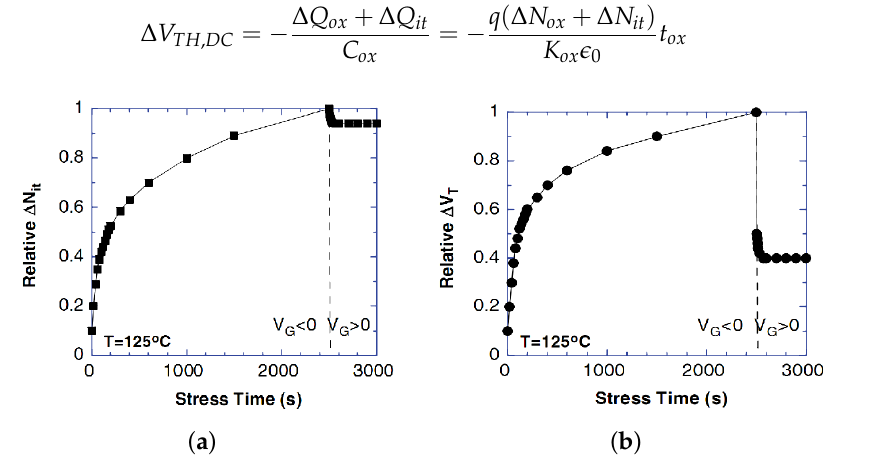
Figure 4. ( a ) Relative generation of interface traps in the device and ( b ) the threshold voltage relative change as presented in